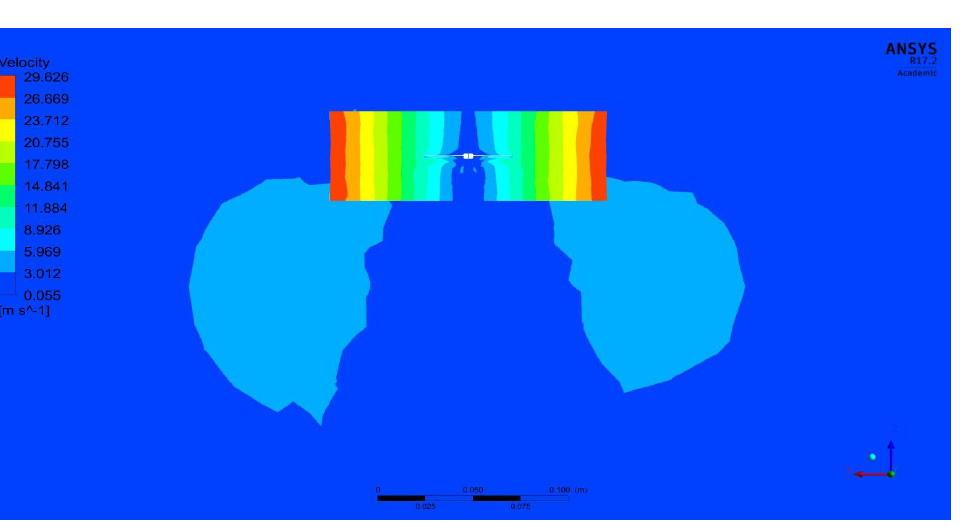
Figure 46. A typical planar representation of hydrodynamic pressure distributions on UAV propeller under the conditions of 3 m/s and 4000 RPM.